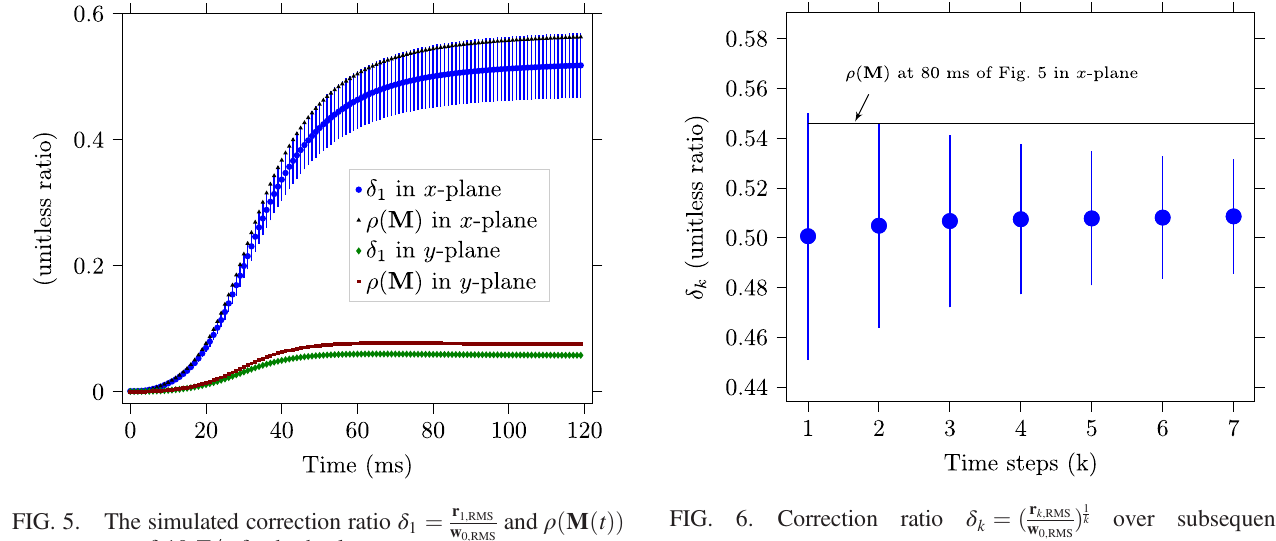
FIG. 5. The simulated correction ratio δ 1 ¼ over a ramp of 10 T = s for both planes.